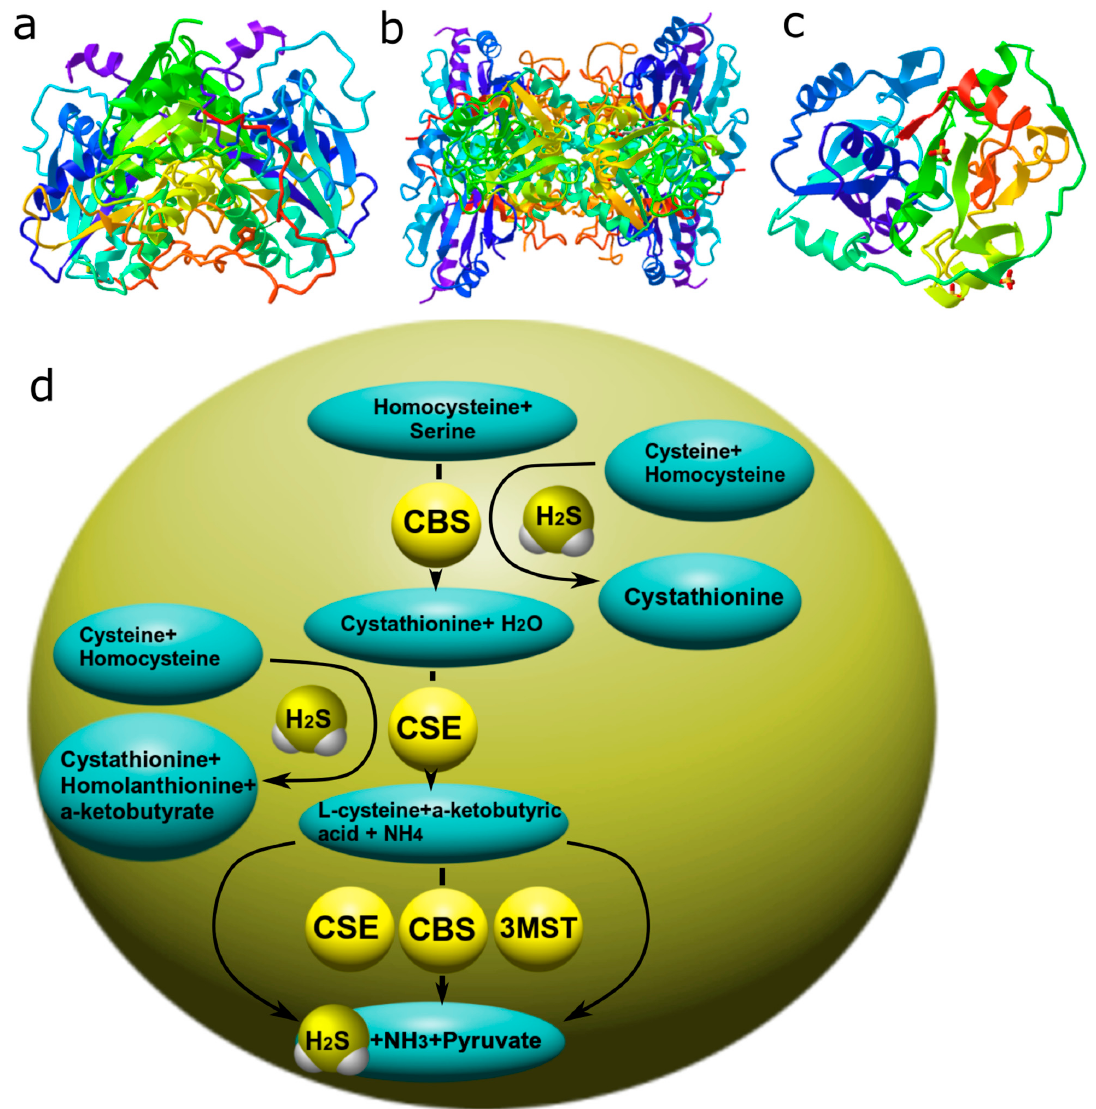
Figure 4. Structural organization of the enzymes responsible for the formation of H 2 S and H 2 S biosyn- thesis. 3D-model of the structural organization: ( a ) cystathionine- β -synthase (CBS), ( b ) cystathionine γ -lyase (CSE), and ( c ) 3-mercaptopyruvate sulfurtransferase (3-MST). ( d ) Variety of pathways